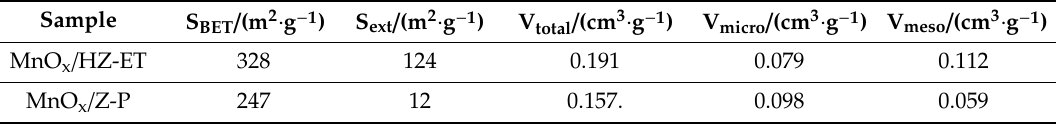
Table 2. Structural properties of the catalysts.